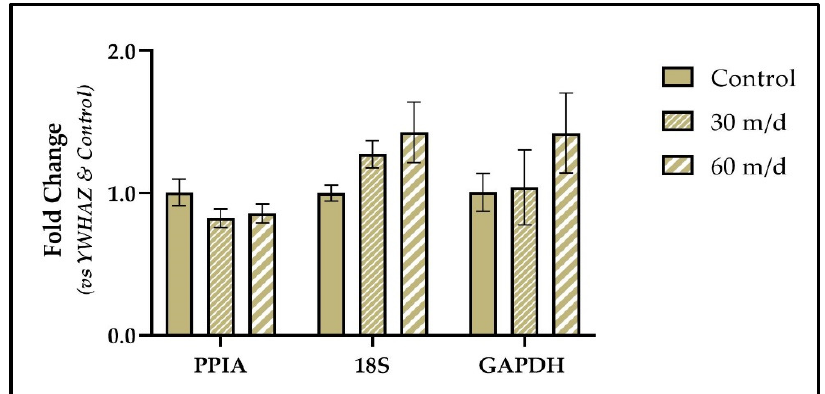
Figure 2. Alamar Blue metabolic activity assay results for Y201 cells seeded at 5000, or 10,000 cells/cm 2 on day 5 in either unstimulated (control) conditions, or under ES of 30 or 60 min per day (m/d). * p < 0.05 versus unstimulated control cells seeded at 10,000 cells/cm 2 ; & p < 0.05 versus all three 10,000 cells/cm 2 groups. N = 3 for controls, and N = 5 for ES groups. Statistical analysis performed by a two-way ANOVA, and Tukey’s multiple comparisons test.